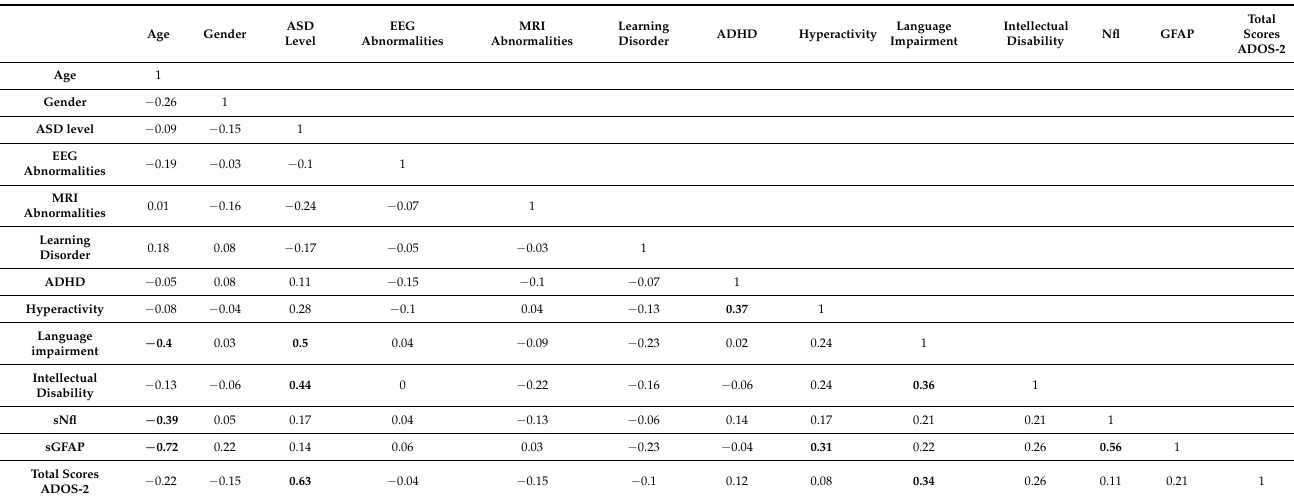
Table 2. Matrix of Spearman’s correlation test